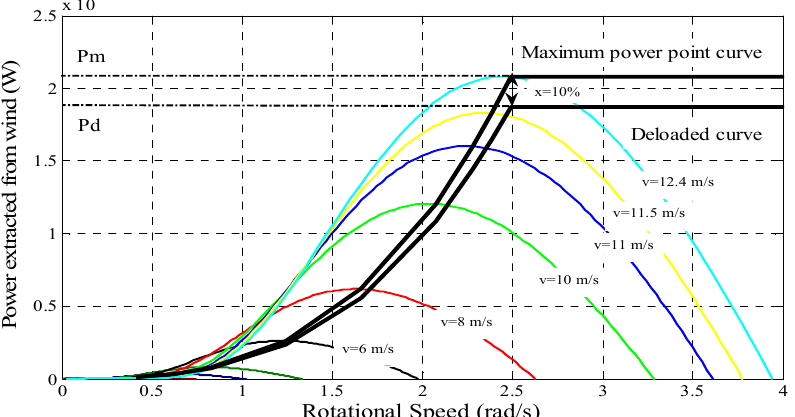
Figure 2. Wind turbine characteristics with de-loaded and maximum power point tracking.